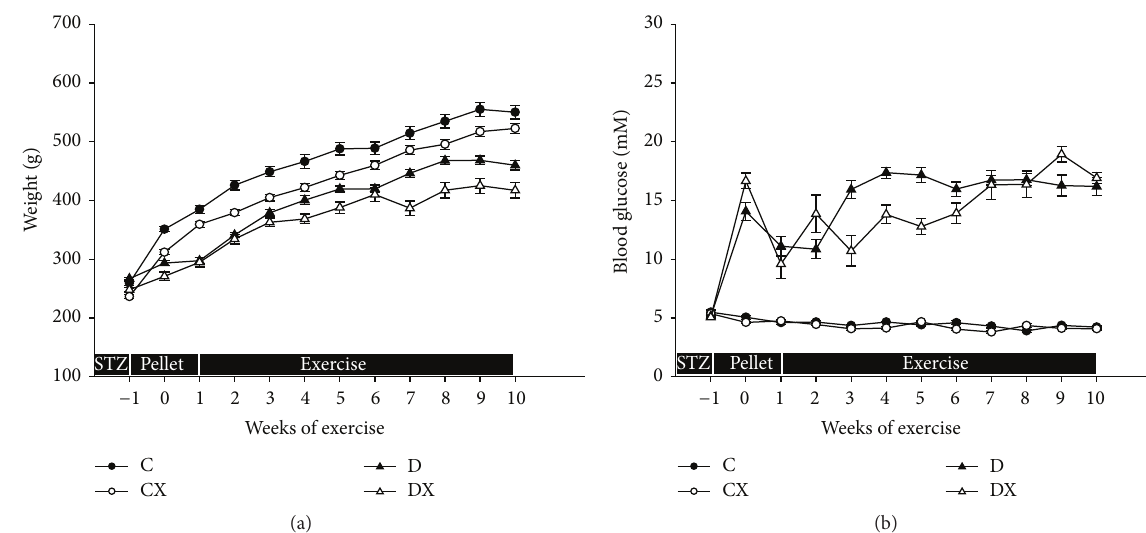
Figure 1: (a) Weekly body weights: C, sedentary control ( 𝑛 = 16 ); CX, control exercise ( 𝑛 = 16 ); D, sedentary T1DM ( 𝑛 = 15 ); DX, T1DM exercise ( 𝑛 = 12 ). (b) Weekly blood glucose concentrations: C ( 𝑛 = 16 ); CX ( 𝑛 = 15 ); D ( 𝑛 = 15 ); DX ( 𝑛 = 13 ). STZ, pellet, and exercise indicate the periods of STZ injection, insulin pellet implantation, and aerobic exercise, respectively. Significantly different groups ( 𝑝 < 0.05 ). Data are mean ± SE. There was significant difference in body weight between T1DM and non-T1DM groups, while a significant difference was evident between exercised and nonexercised groups. The blood glucose concentrations in the T1DM groups were significantly different than non-T1DM groups.